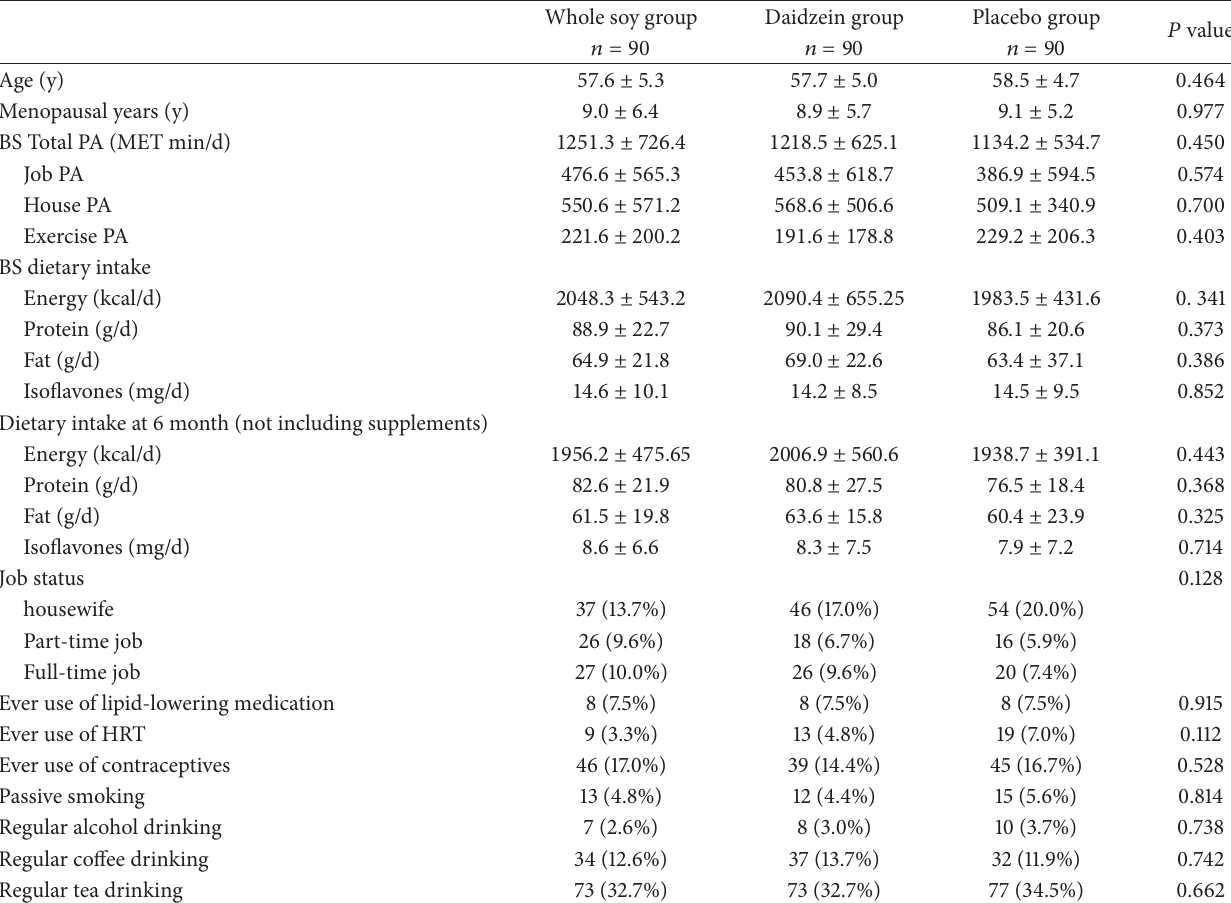
Table 2: Baseline characteristics among 3 study